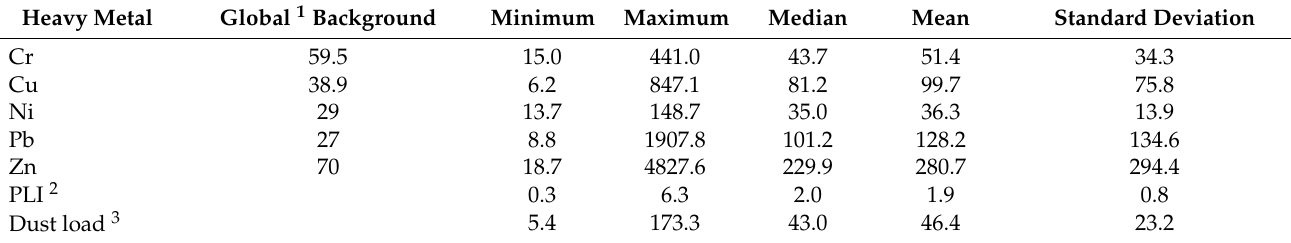
Table 1. The descriptive statistics of the heavy metal concentrations (mg/kg) in the 482 road dust samples.